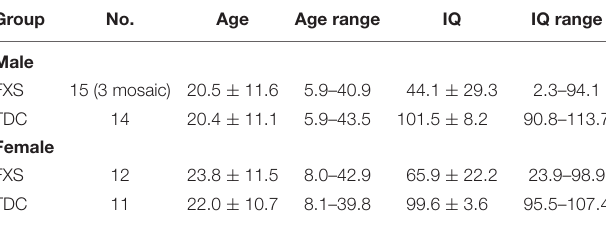
TABLE 1 | Characterization of FXS and control subjects.